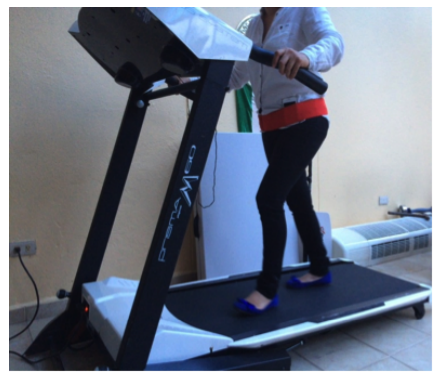
Figure 3. Calibration